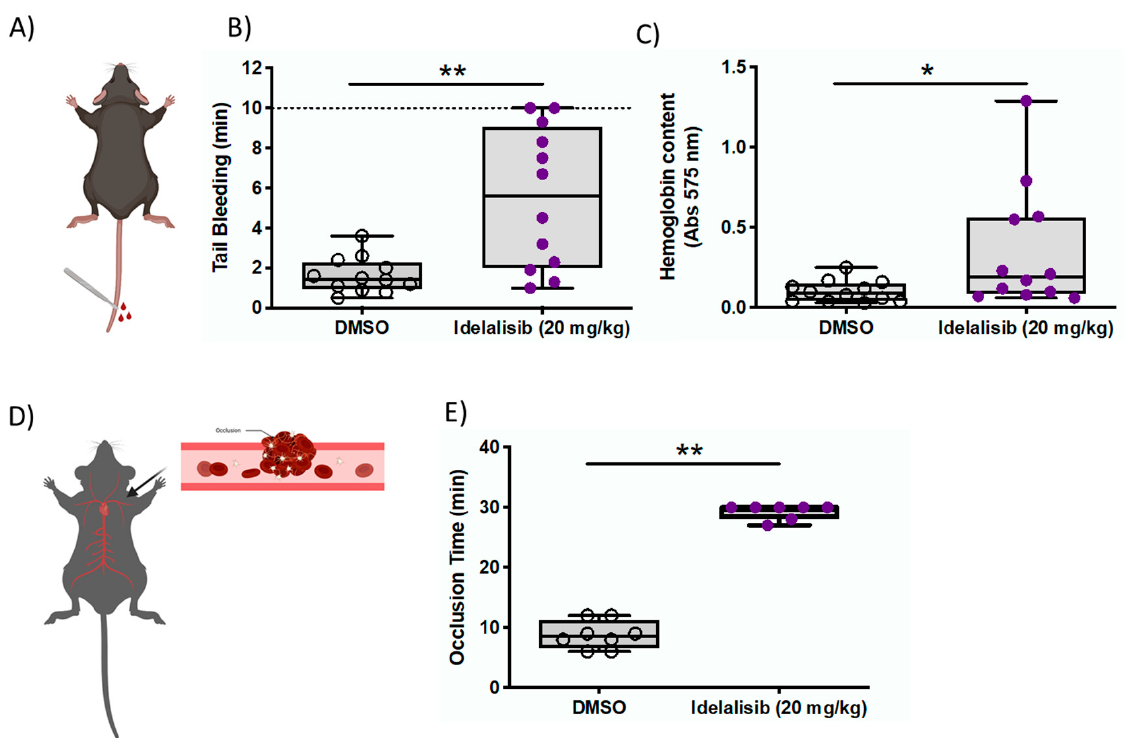
Figure 4. Idelalisib reduces thrombus formation with minor bleeding effects in mice. ( A ) Picture representing the tail bleeding assay. ( B ) The bleeding time was higher in the treated animals although values were always below 10 min. ( C ) The hemoglobin content of blood collected during bleeding was higher in the treated animals. ( D ) Picture representing the FeCl 3 -induced arterial thrombosis model. ( E ) Idelalisib-treated mice display significantly longer occlusion times than control mice. * p < 0.05; ** p <0.01.